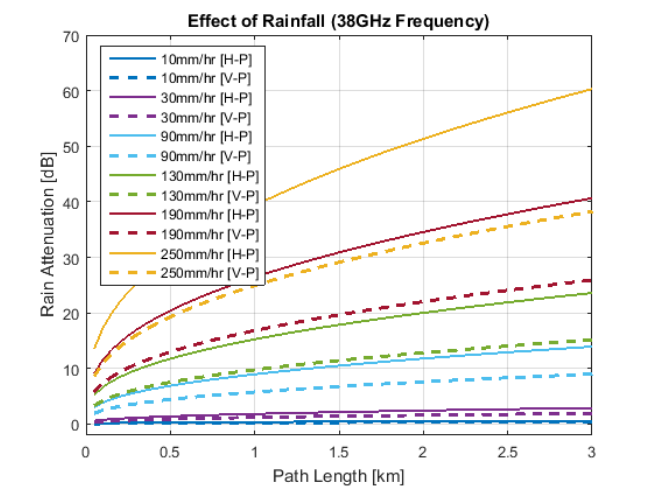
Fig 33. Effect of rainfall (3 km, 38 GHz) Figure (fig. 34) will show the effect of rainfall and the amount of rain attenuation on different carrier frequencies for a path length of 3 kilometers with a rain rate of 100